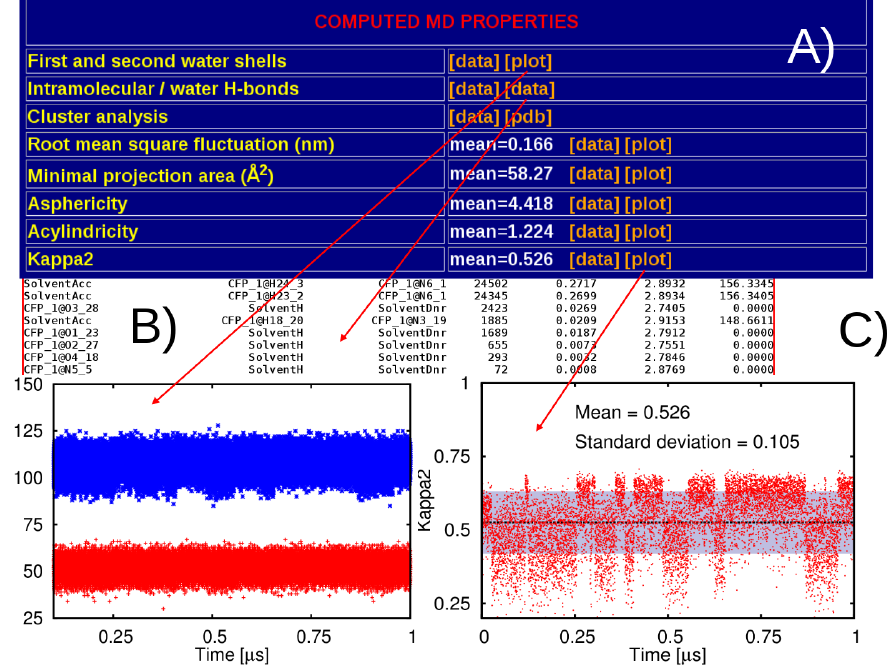
Figure 5. Snapshots of the some of the molecular properties exctracted from MD trajectories ( A ); as an example we report first and second water shells and statistics of solute-solvent H-bonds ( B ), and the dynamical behaviour of the relative shape anisotropy ( C